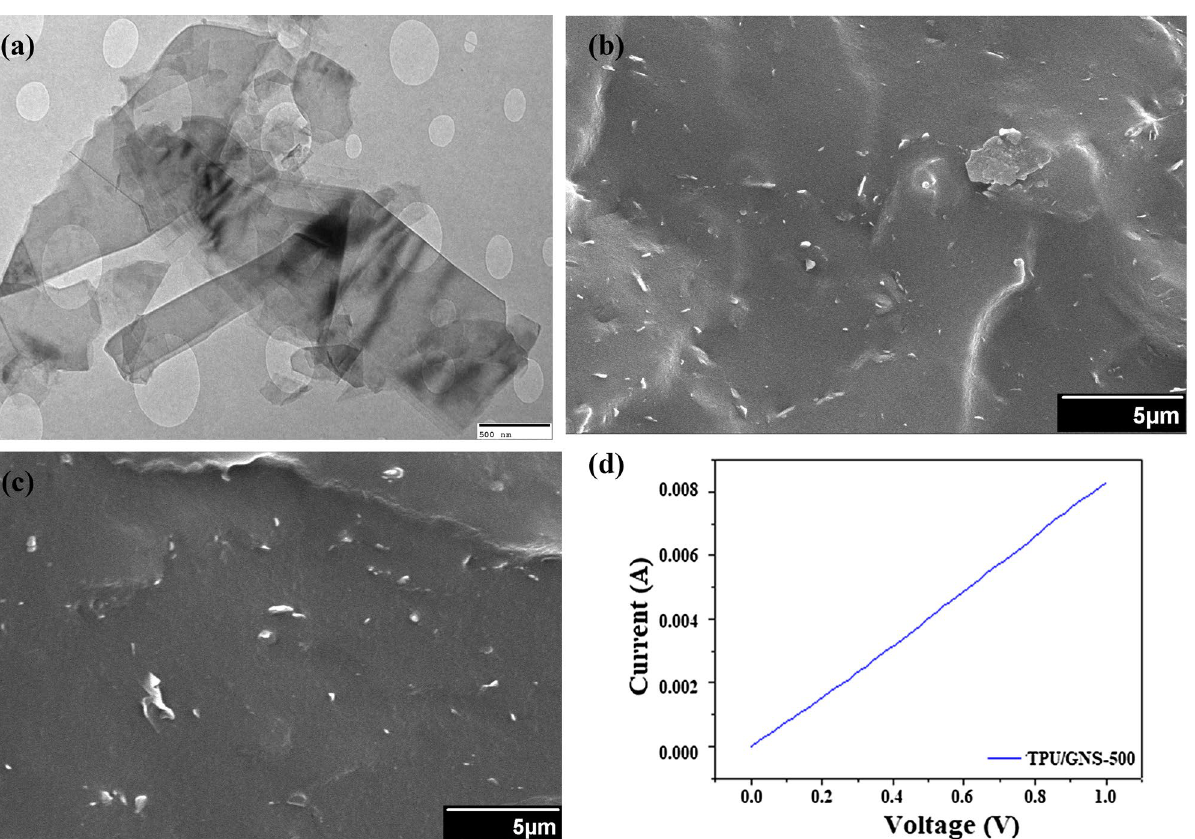
Figure 5. ( a ) GNS-500 representative TEM image showing few layered graphene nanosheets ( b , c ) Cross- sectional morphology ( d ) Electrical conductivity (DC) of TPU/GNS-500